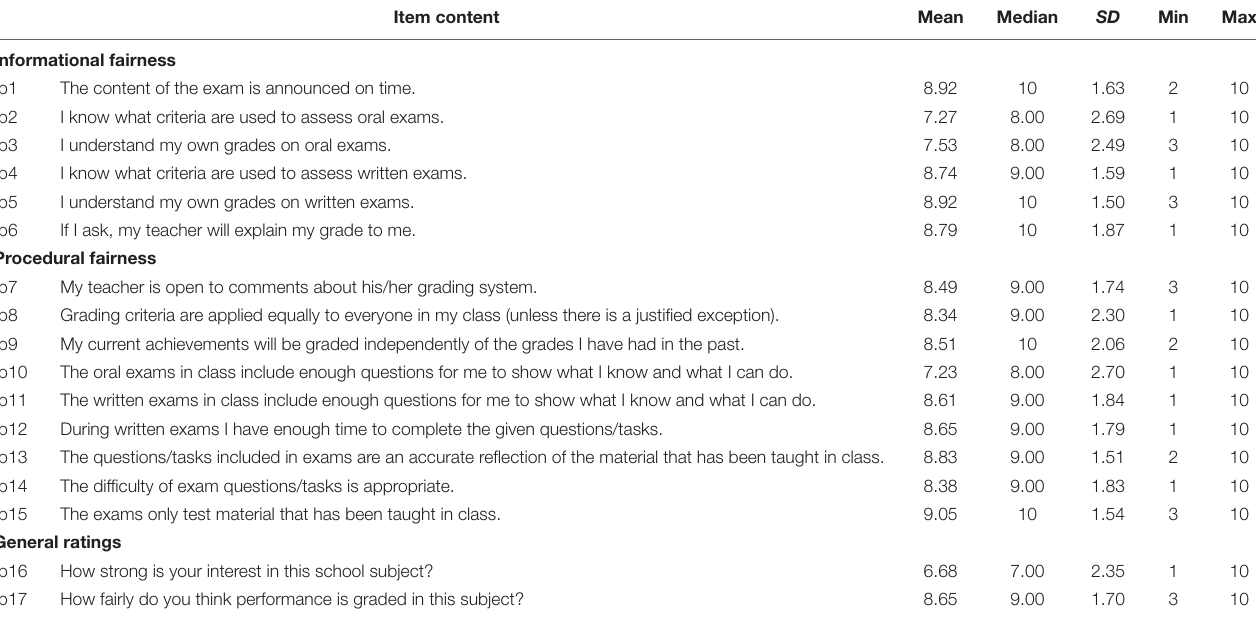
TABLE 1 | Item content and descriptives within the student sample ( n = 168).